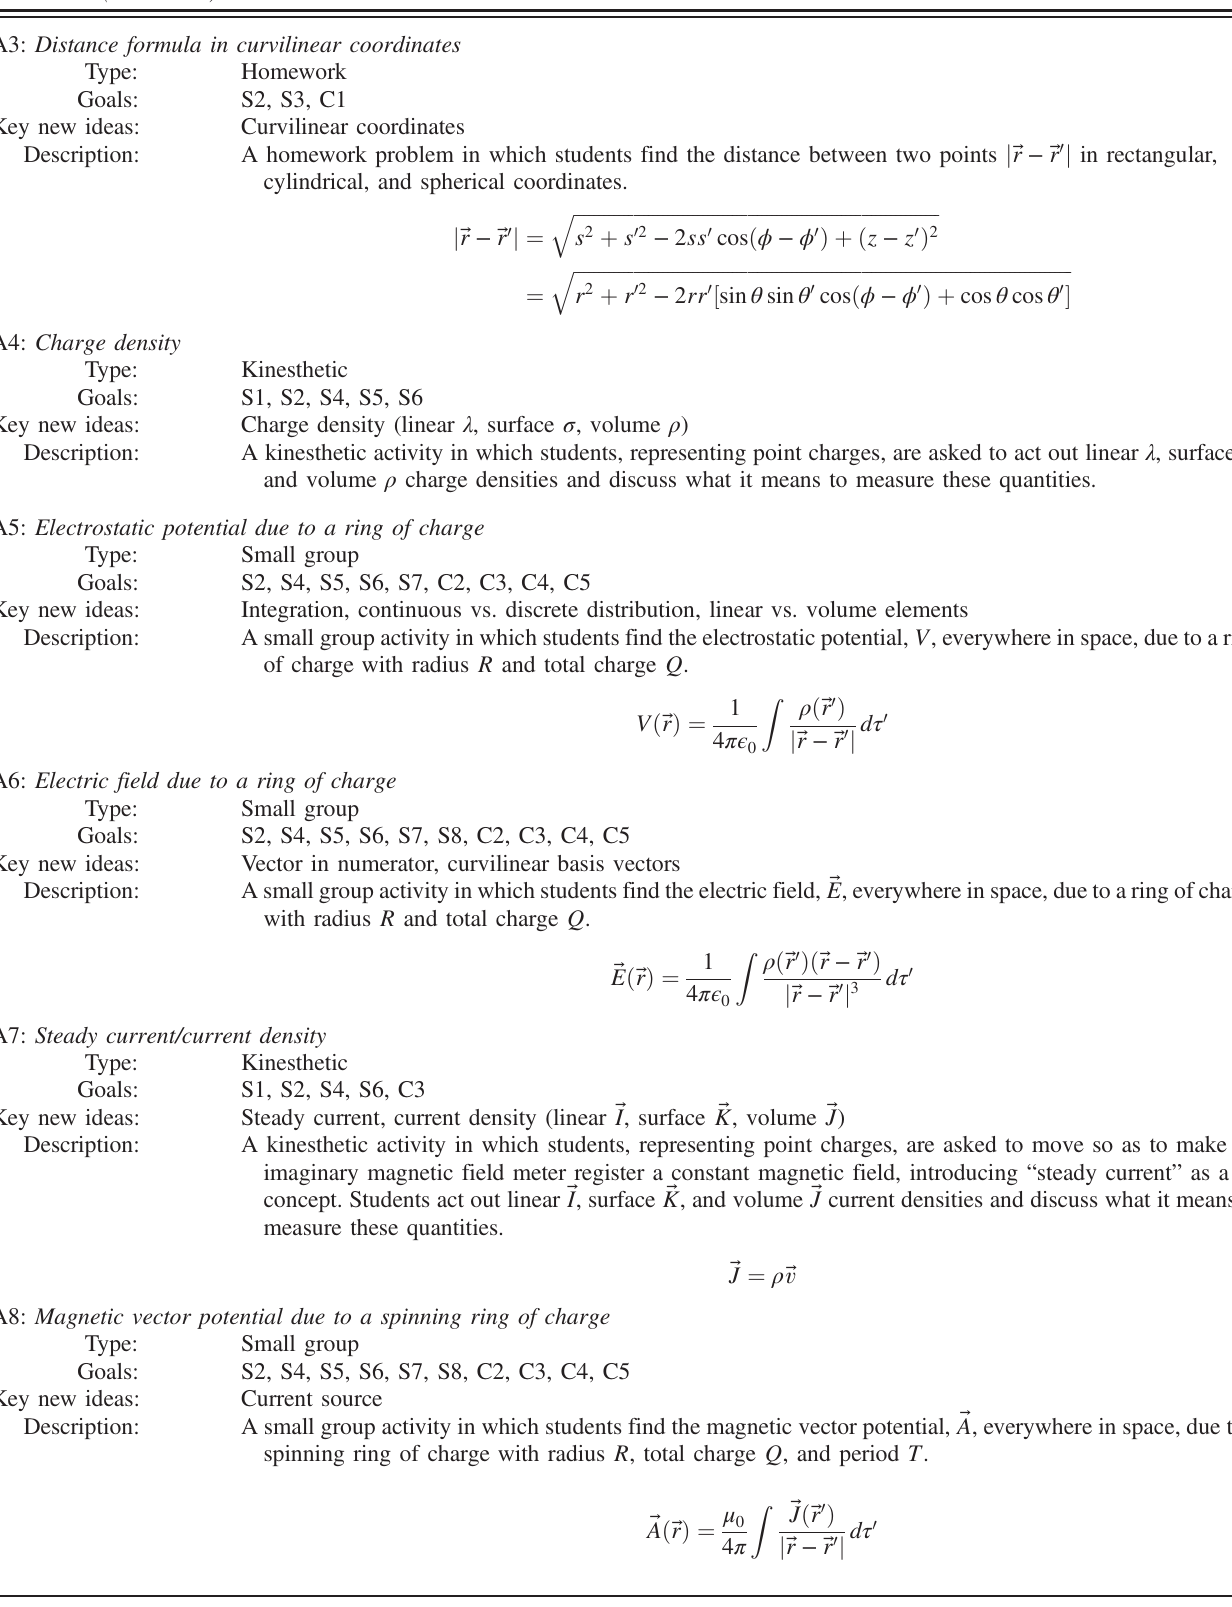
A8: Magnetic vector potential due to a spinning ring of charge Type: Small group Goals: Current